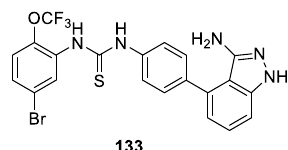
Figure 33. Chemical structures of 2 H -indazole derivatives 131 and 132.